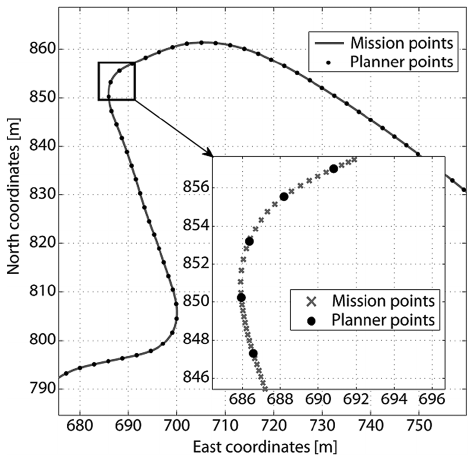
Fig. 2. Example of the trajectory